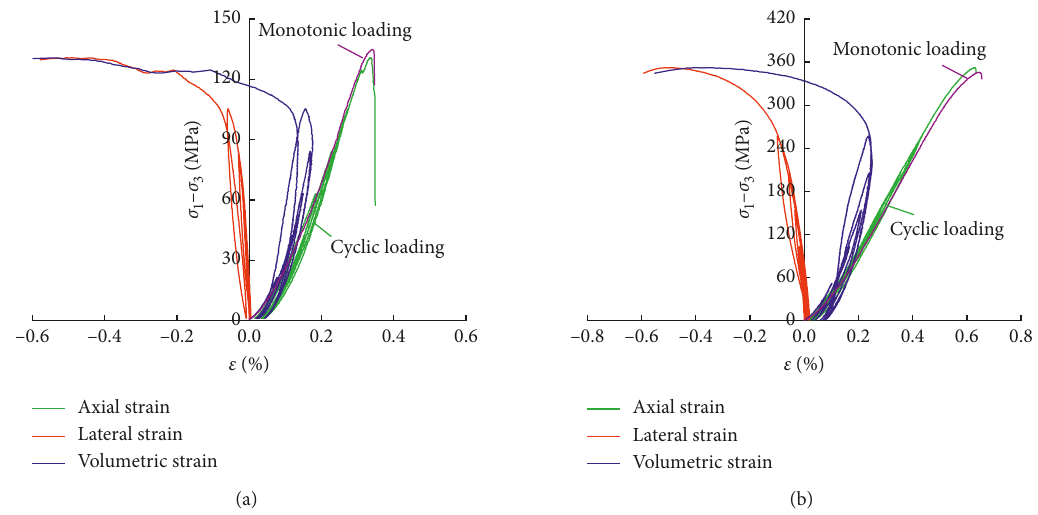
Figure 3: Stress-strain curves of samples under monotonic and cyclic loading. (a) σ